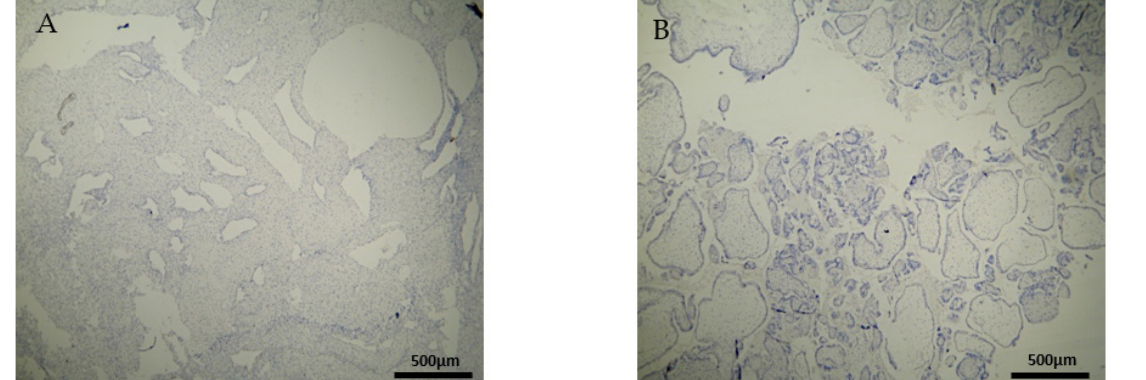
Figure 6 . Evaluation of positive CD8 antigen expression. Control group (CG): ( Α ) Negative CD8 expression in the decidua parietalis (4 × 4 magnification). ( Β ) Almost negative CD8 expression in the chorionic villi (trophoblast) (4 × 4 magnification).